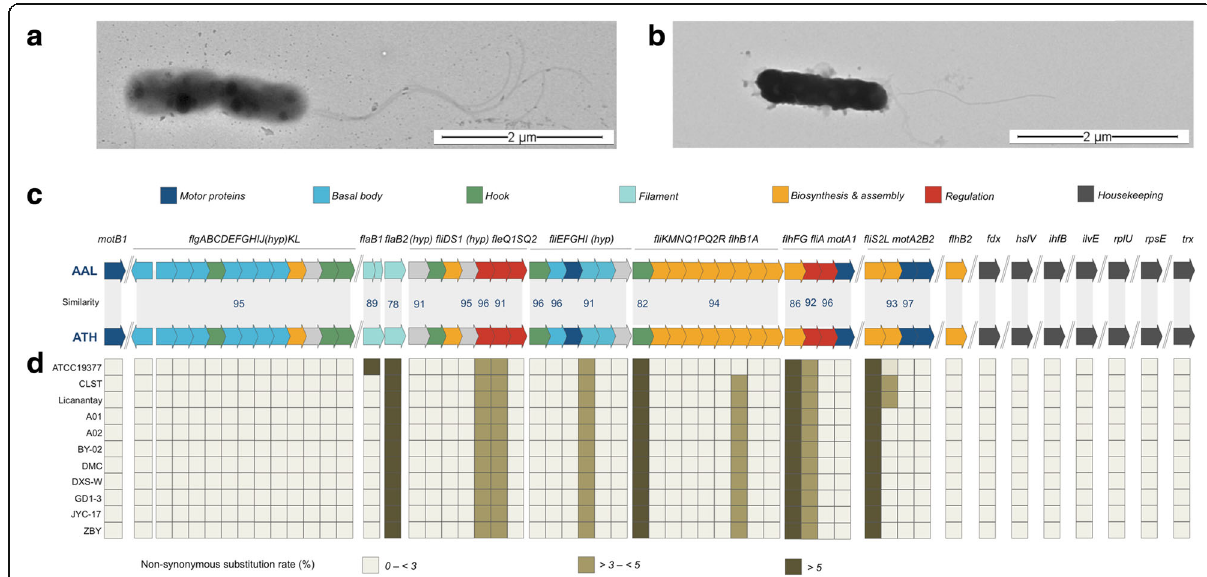
Fig. 3 Flagellation patterns in A. albertensis T and A. thioxidans T . a Transmission electron micrograph showing a dividing A. albertensis DSM 14366 T cell with tuft of polar flagella and b a cell of A. thiooxidans ATCC 19377 T with a single polar flagellum. c Comparison of the flagellar gene cluster between A. albertensis T (AAL) and A. thiooxidans T (ATH) derived from the corresponding genomic sequences. Flagellar genes and gene clusters are indicated accordingly. Percentage of amino-acid similarity is indicated only when bellow 98%. Color coding is as follows: motor proteins (blue), basal-body (turquoise), hook (green), flagellin (light blue), biosynthesis and assembly functions (orange), regulation (red). d Heatmap of the non-synonymous amino acidic substitution rates (percent) of the protein products of each flagellar gene and seven housekeeping genes from A. albertensis T and 11 A. thioxidans T sequenced strains (AFOH01, LGYM01, JMEB01, AZMO01, LWSA01, LWRZ01, LWSB01, LWRY01, LWSC01, LWSD01, LZYI01). Housekeeping genes were chosen after Nuñez et al.